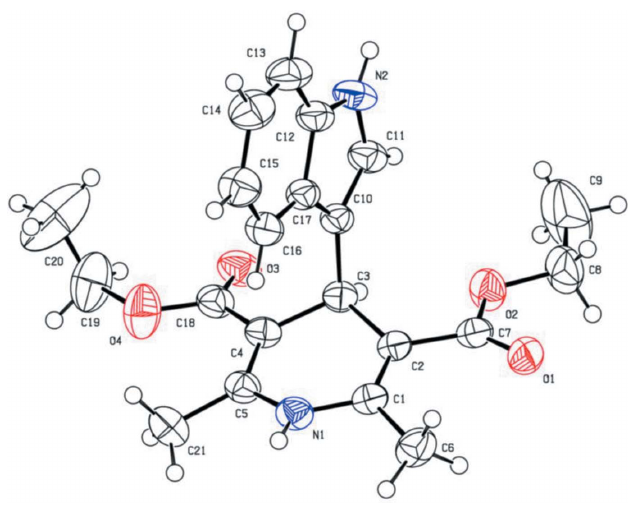
Figure 1 The molecular structure of the title compound, showing the atom- labelling scheme with displacement ellipsoids drawn at the 30% probability